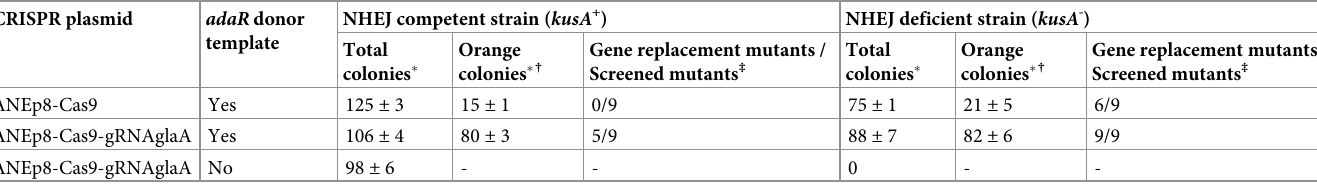
Table 5. CRISPR/Cas9-mediated targeting homologous integration in A . niger . CRISPR